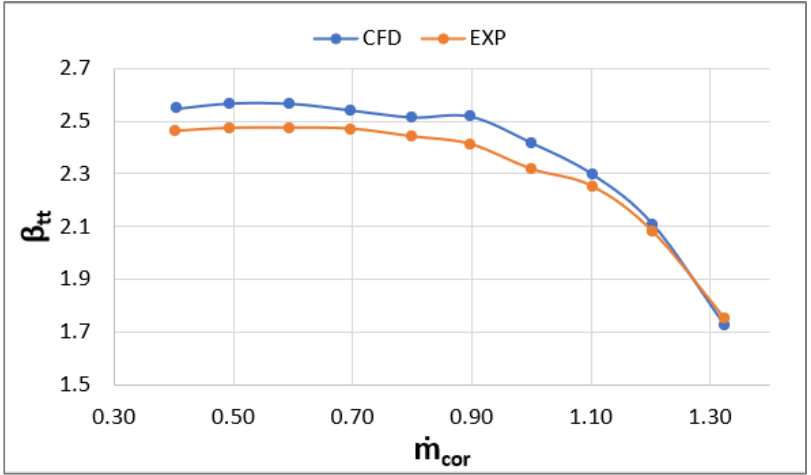
Figure 5. Comparison of the pressure ratio curve of the centrifugal compressor with ported shroud obtained from the CFD Simple + Volute model with respect to the experimental data, at the design rotational speed of N cor = 1.0.